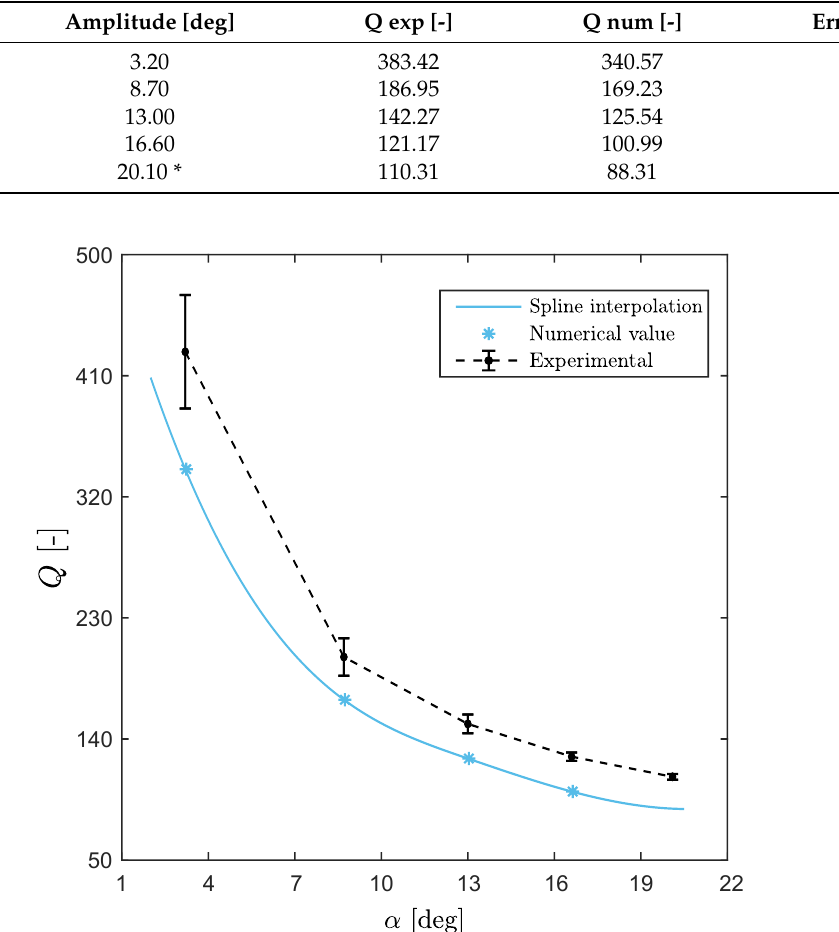
Figure 8. Comparison between experimental and numerical quality factors for Micromirror 1. The dependence of Q on the maximum aperture α is strongly